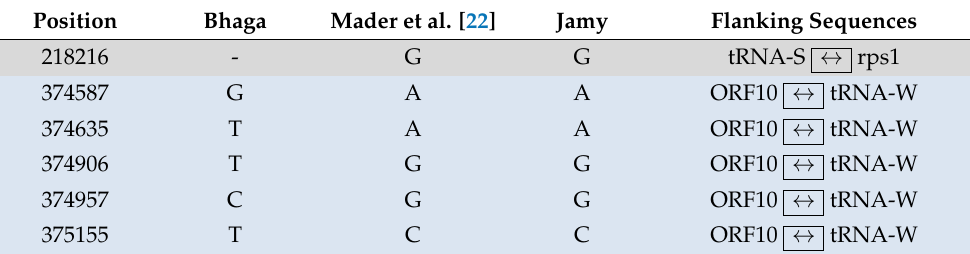
Figure 1. Circular representation of the mitochondrial genome of Fagus sylvatica (Bhaga) with gene locations on both strands and an indication of SNP and indel locations indicated in yellow on the inner red and blue circles, representing Jamy and the individual sequenced previously [22]. Table 1. Variable positions in the mitochondrial genomes of the three individuals investigated in this study. Indel positions are shaded in grey. SNPs private to Bhaga are shaded in blue, SNPs private to the mitochondrial genome reported in Mader et al. [22] are shaded in